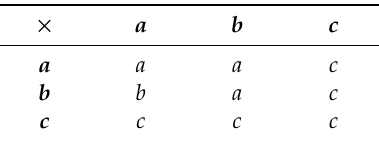
Table 1. The operation × on S .